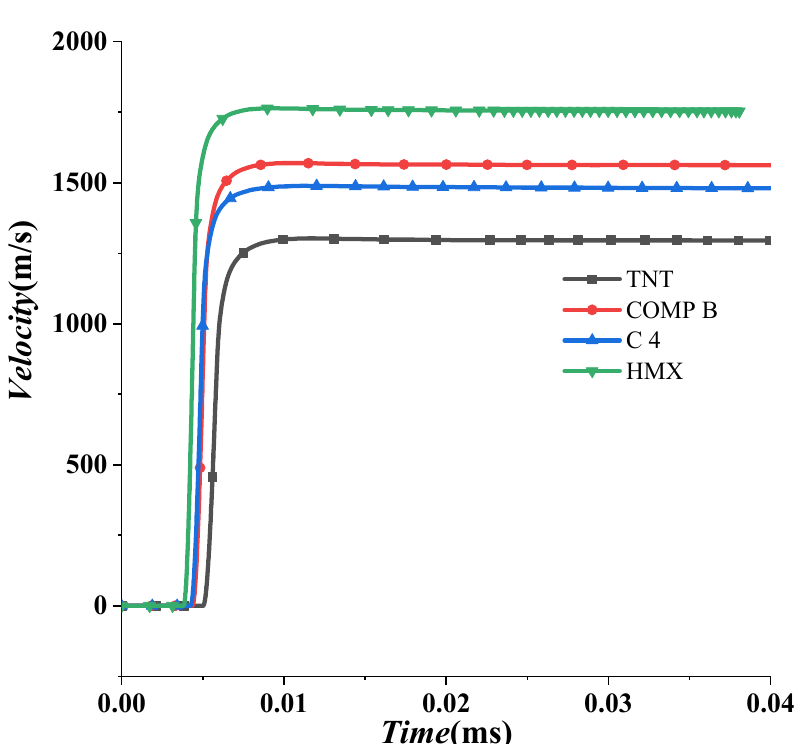
Figure 12. Evolutions of the maximum head velocity of projectiles with different types of charges in air.